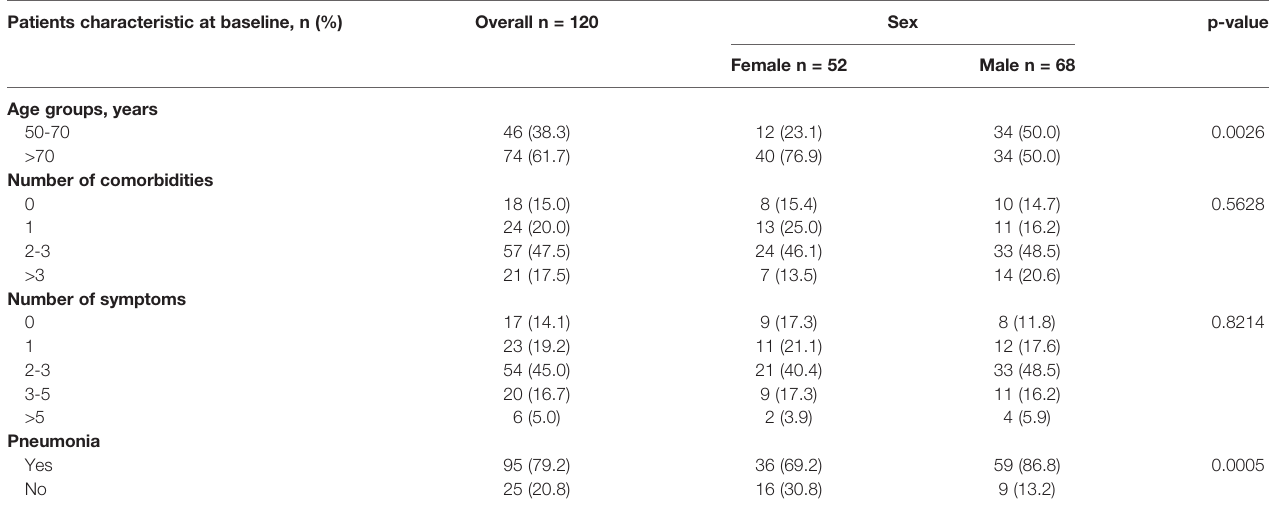
TABLE 2 | Main characteristics at baseline in 120 patients 50 years and over, strati fi ed by sex. Patients characteristic at baseline, n (%)